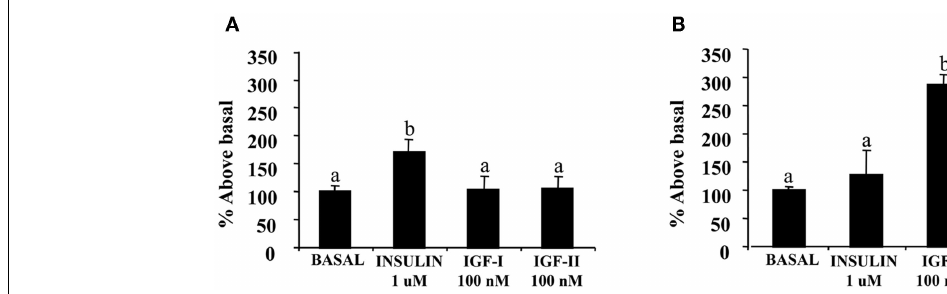
against GLUT4 (final dilution 1:500) and a secondary antibody anti-rabbit (1:5000). Results are expressed as percentage of band intensity above basal and mean ± SE ( n = 3 experiments). Statistical differences between conditions were analyzed by one-way ANOVA followed byTukey’s post hoc test. Different letters indicate significantly ( P < 0.05) different values among groups.